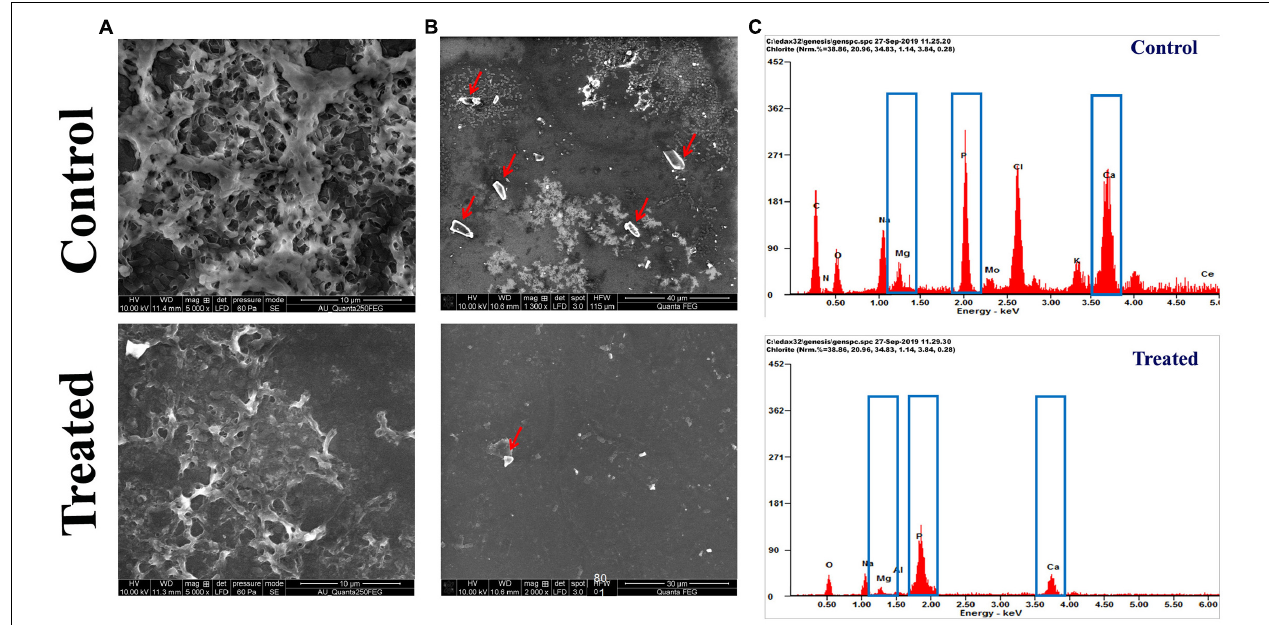
FIGURE 4 | Effect of HMB (at its MBIC) on Proteus mirabilis crystalline biofilm production. FESEM analysis of (A) crystalline biofilm matrix and (B) formation of salt crystal precipitates (indicated by red arrow) and (C) energy-dispersive X-ray EDAX analysis of P. mirabilis struvite production in the presence and absence of HMB at MBIC. HMB, 2-hydroxy-4-methoxybenzaldehyde; MBIC, minimum biofilm inhibitory concentration; EDAX, energy-dispersive